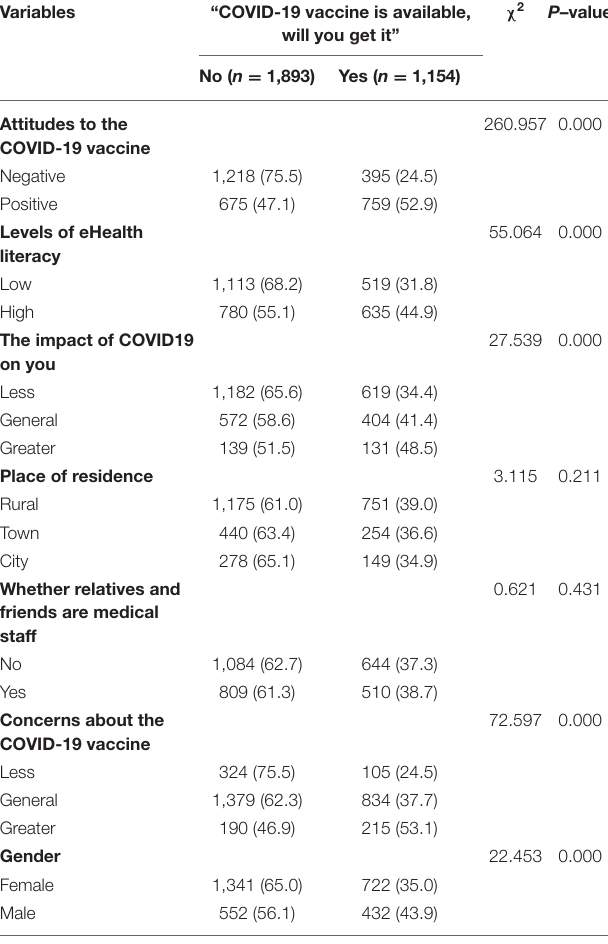
TABLE 1 | Sociodemographic characteristics of the study sample ( N = 3,047). Variable